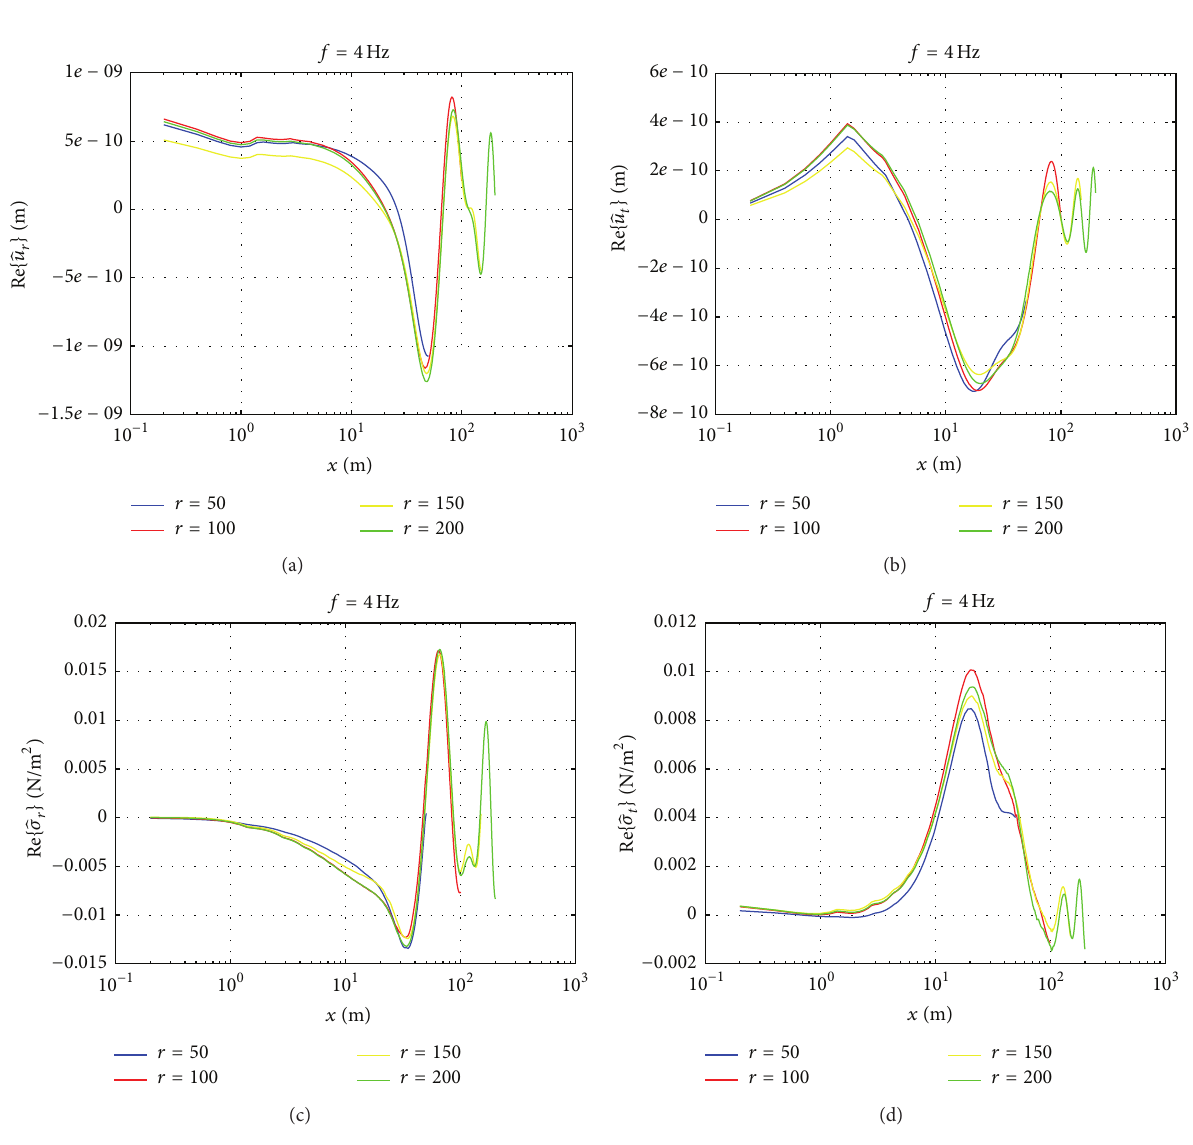
Figure 6: Radial displacement and stress for ℎ = 30 m and 𝑓 = 4 Hz.